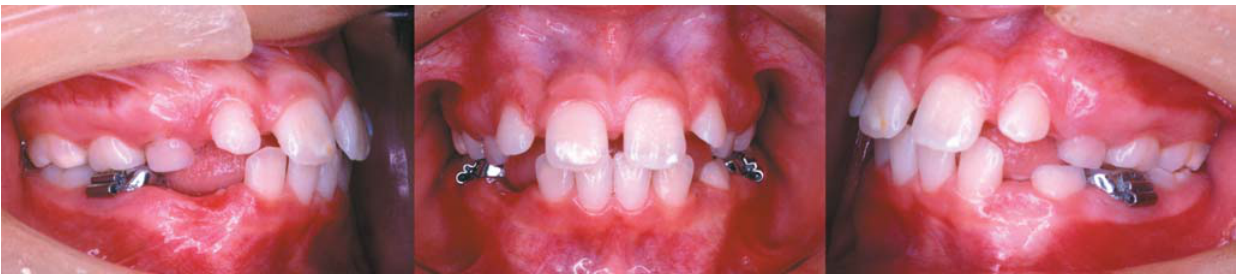
FIGURE 4- Frontal and lateral views after interceptive treatment (10 years old)